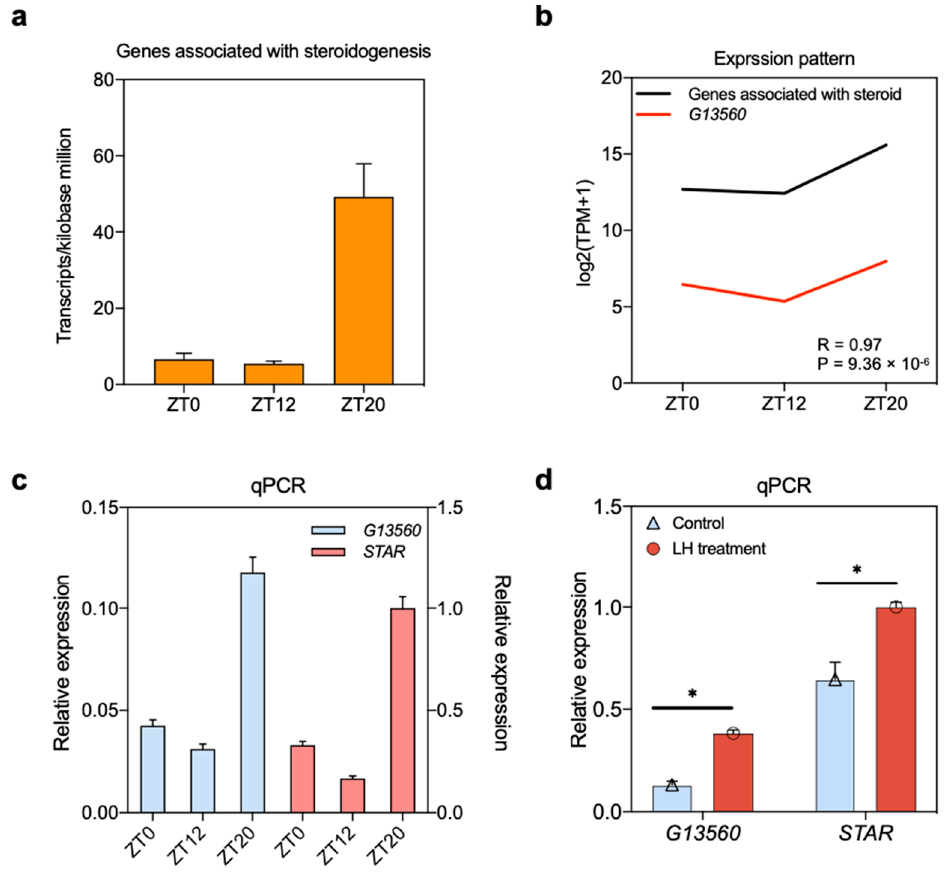
Figure 6. Expression and function of lncRNA G13560 in follicle development during the chicken ovulatory cycle. ( a ) Expression of genes associated with steroid regulation was up-regulated in the ZT20 stage compared with the other two stages. ( b ) lncRNA was co-expressed with these steroid-related genes and displayed a similar expression pattern. ( c ) lncRNA G13560 expression was confirmed by qRT-PCR among the three development stages. Data are shown as mean ± SD. ( d ) Co-expression of lncRNA and mRNA was validated in cultured granulosa cells with or without LH treatment. STAR , steroidogenic acute regulatory protein; GAPDH was used as a control. Data are means ± SD and are representative of at least three independent experiments. * p < 0.05. ZT0 (9:00 a.m.), ZT12 (9:00 p.m.), and ZT20 (5:00 a.m.) represent the early, middle, and LH surge stages, respectively, of the chicken ovulatory